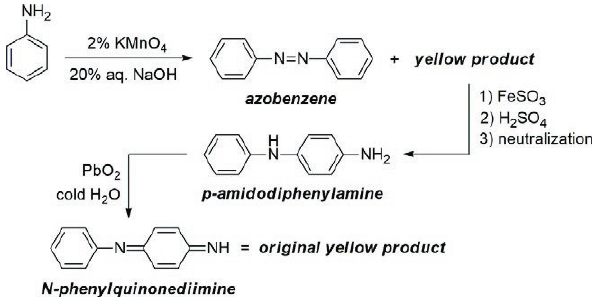
Figure 5. Caro’s synthesis and identification of the intermediate oxi- dation product N -phenylquinonediimine.